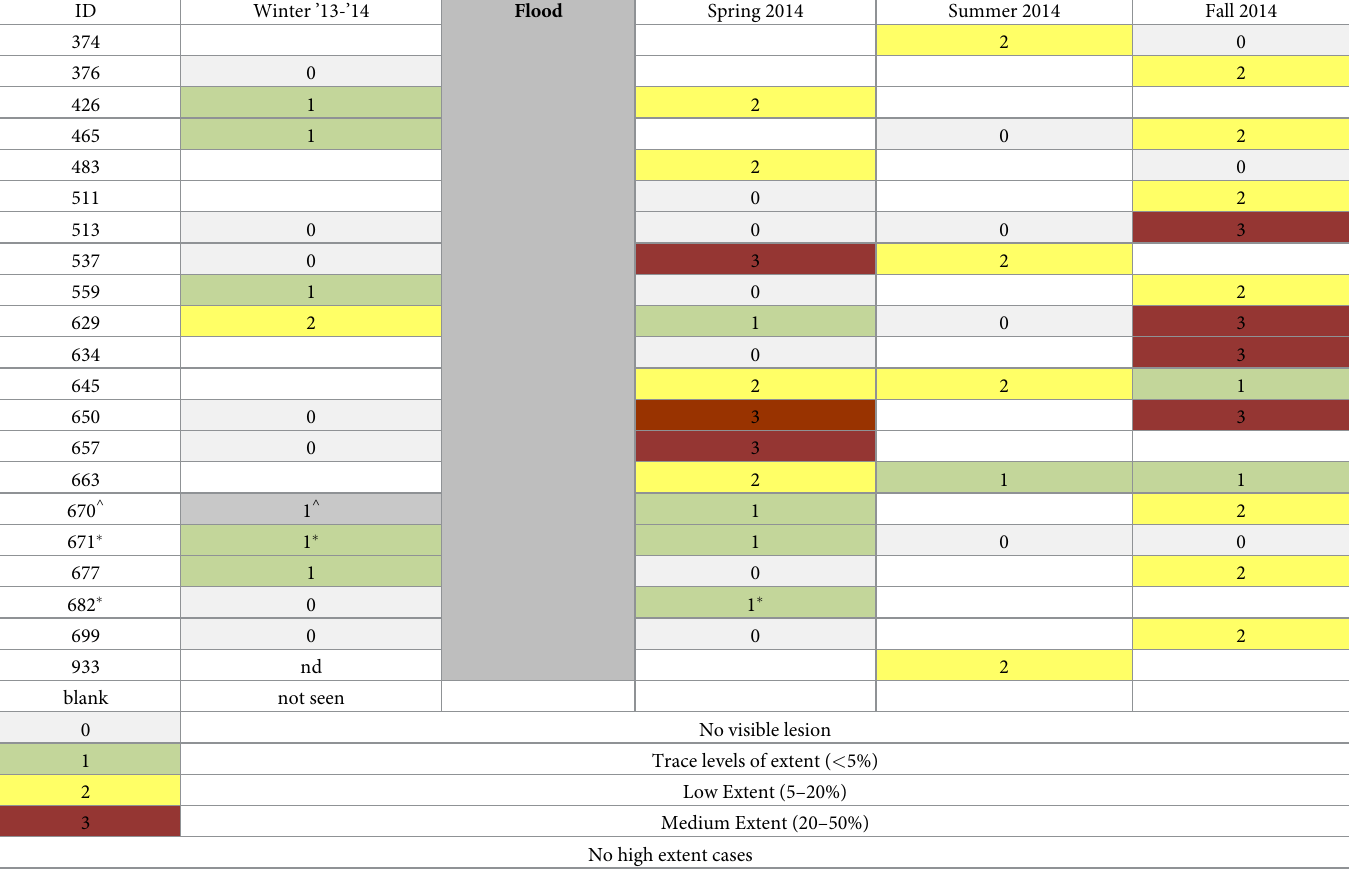
Table 4. Lesion extent progression over time in 21 individuals that demonstrated lesion extent � 5% at least once in the four seasons evaluated. ID